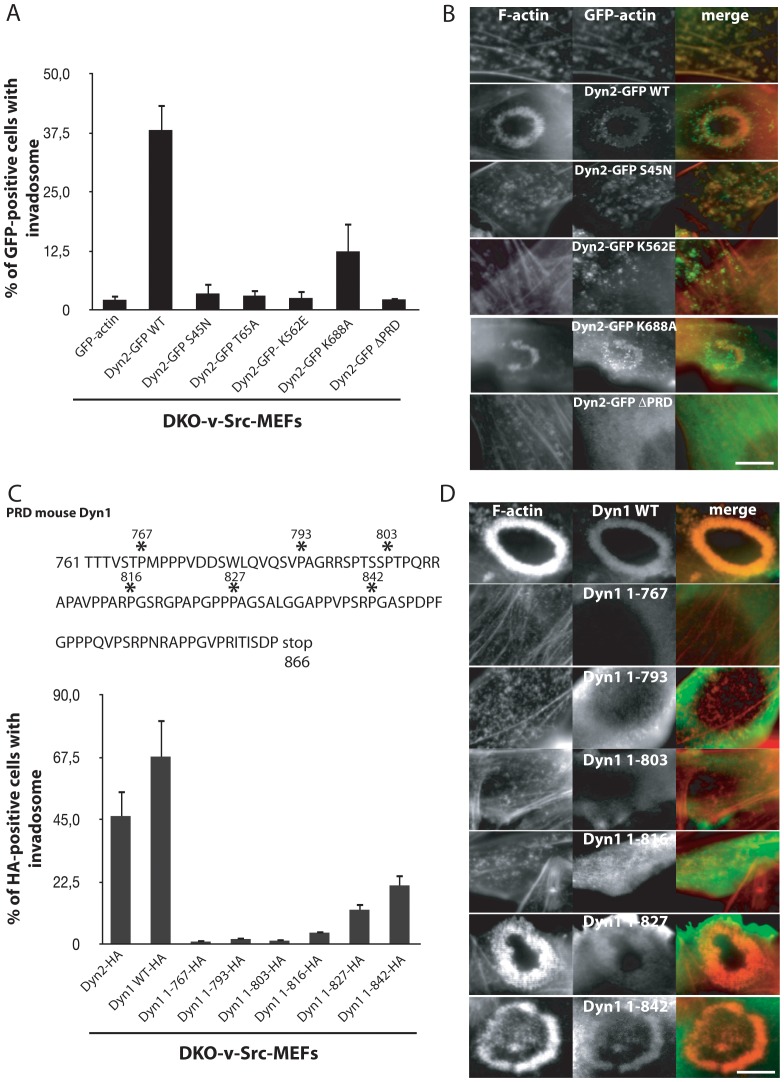
Dynamin function in invadosome is dependent of a coordinated activity of its GTPase, PH and GED domains.A) Re-expression of multiple dynamin mutants (450≤n<650 invadosomes) revealed that GTPase, PH domain and PRD domains have cooperative functions to rescue invadosome formation in in DKO-v-Src-MEFs. B) The PRD is only essential domain for dynamin localization in F-actin structures (small actin punctates or invadosomes). C) Amino-acyl sequence of the PRD domain of mouse dynamin 1 where the sites of the multiple stop in the PRD sequence are indicated by an asterisk (*). Increasing PRD length is essential to rescue invadosome formation in DKO-v-Src-MEFs (450≤n<650 invadosomes). D) The ability to rescue invadosome formation is linked with the ability to relocalize to F-actin structures. Scale bar = 5 µm (A, B).